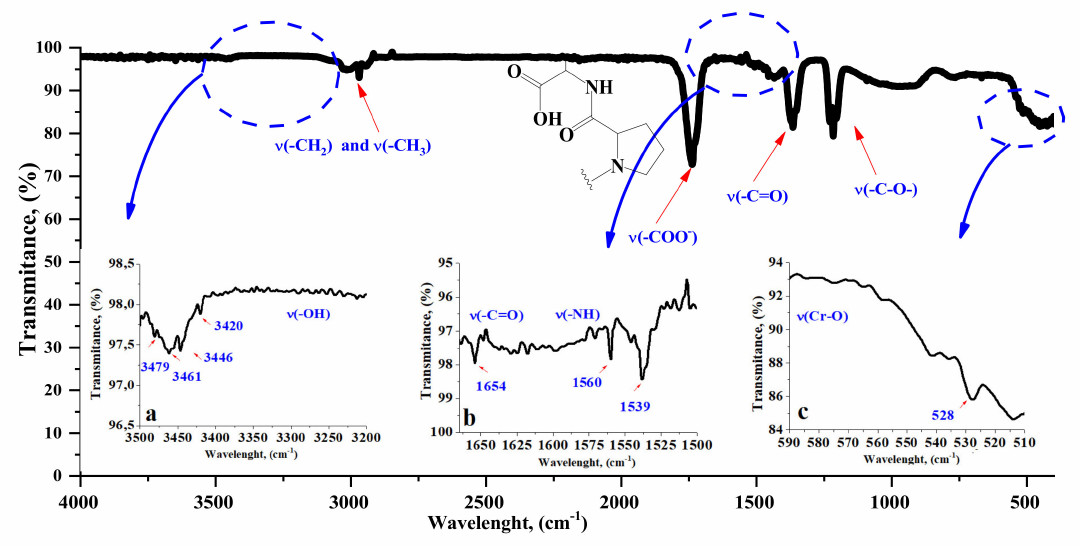
Figure 1. IR spectra of bu ffi ng dusts of collagen with ranges: ( a ) 3500–3200 cm − 1 ; ( b ) 1650–1500 cm − 1 ; ( c ) 590–510 cm − 1